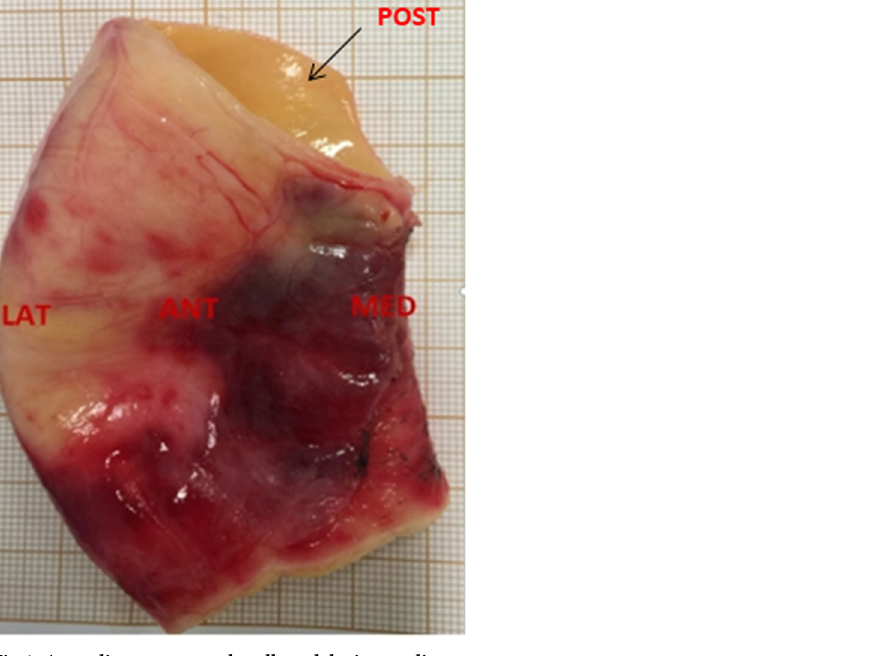
Fig 4. Ascending aorta sample collected during cardiac